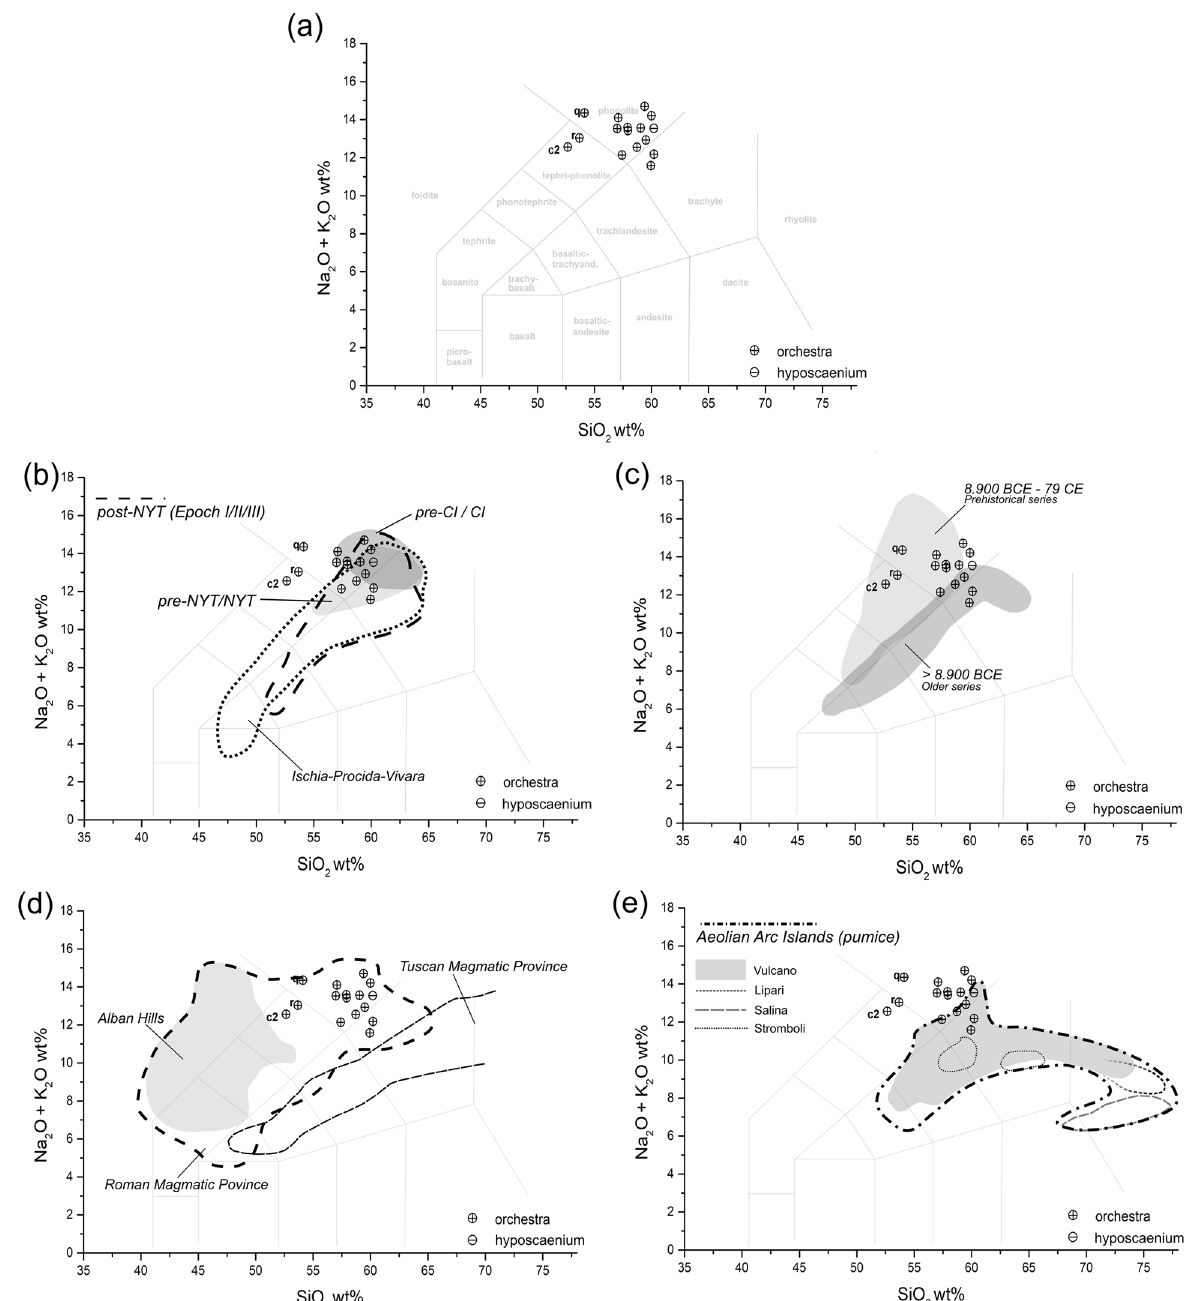
Figure 9. TAS (Total Alkali vs Silica) scatterplots of pumices (volcanic glass) in samples PREP_25 and PREP_53. ( a ) Samples’ distribution according to volcanic rocks’ chemistry (after 79 ); ( b ) samples’ distribution according to rock chemistry of the Phlegraean volcanic products regarding the main eruptive events of the pre- and Campanian Ignimbrite (pre-CI/CI), pre- and Neapolitan Yellow Tuff (pre-NYT/NYT), post-NYT (Epoch I, II, II, according to 82 ), and Phlegraean-correlated volcanoes of Ischia and Procida-Vivara (compositional fields edited from 11,12,80,81 ); ( c ) samples’ distribution in relation to the three main eruptive facies of the Somma- Vesuvius volcanic activities (compositional fields edited from 11,12,81 ); ( d ) samples’ distribution in relation to the fields occupied by the products of the Roman and Tuscan Magmatic provinces (compositional fields edited from 11,83,84 ); ( e ) samples’ distribution in relation to the fields occupied by the pyroclastic products of the Aeolian Arc Isles (compositional fields based on raw data from 85